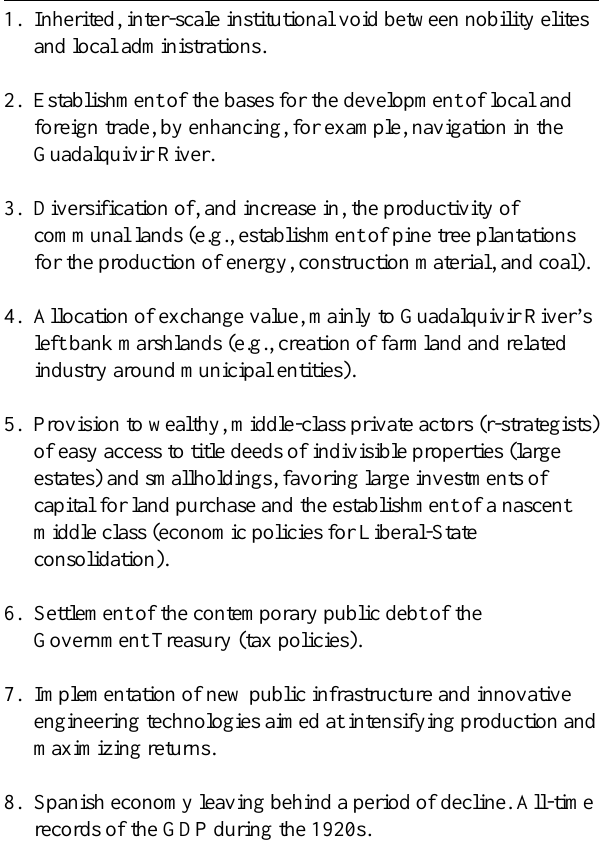
Table 3 . Main institutional events characterizing